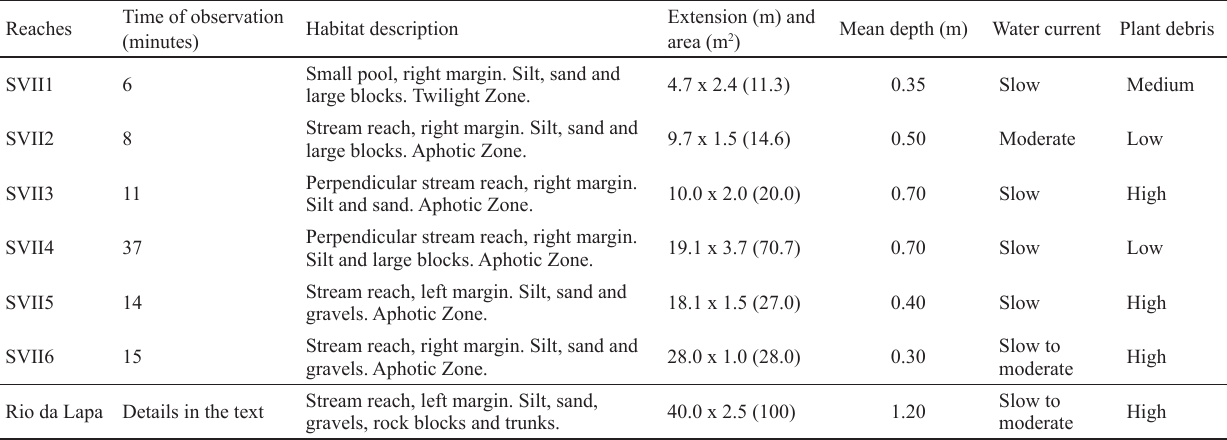
Table 1. Environmental characteristics of stream reaches from the São Vicente II cave (SVII) and epigean rio da Lapa. Plant debris: low (< ½ of the stretch bottom), medium (1/2 of the stretch bottom) or high (> 2/3 of the stretch